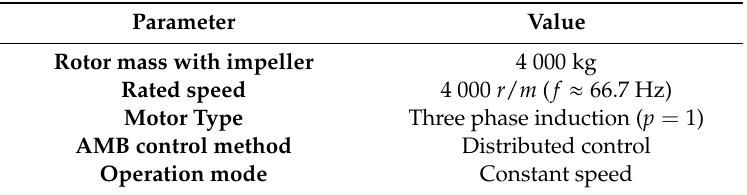
Table 1. The main parameters of PHC-EP.